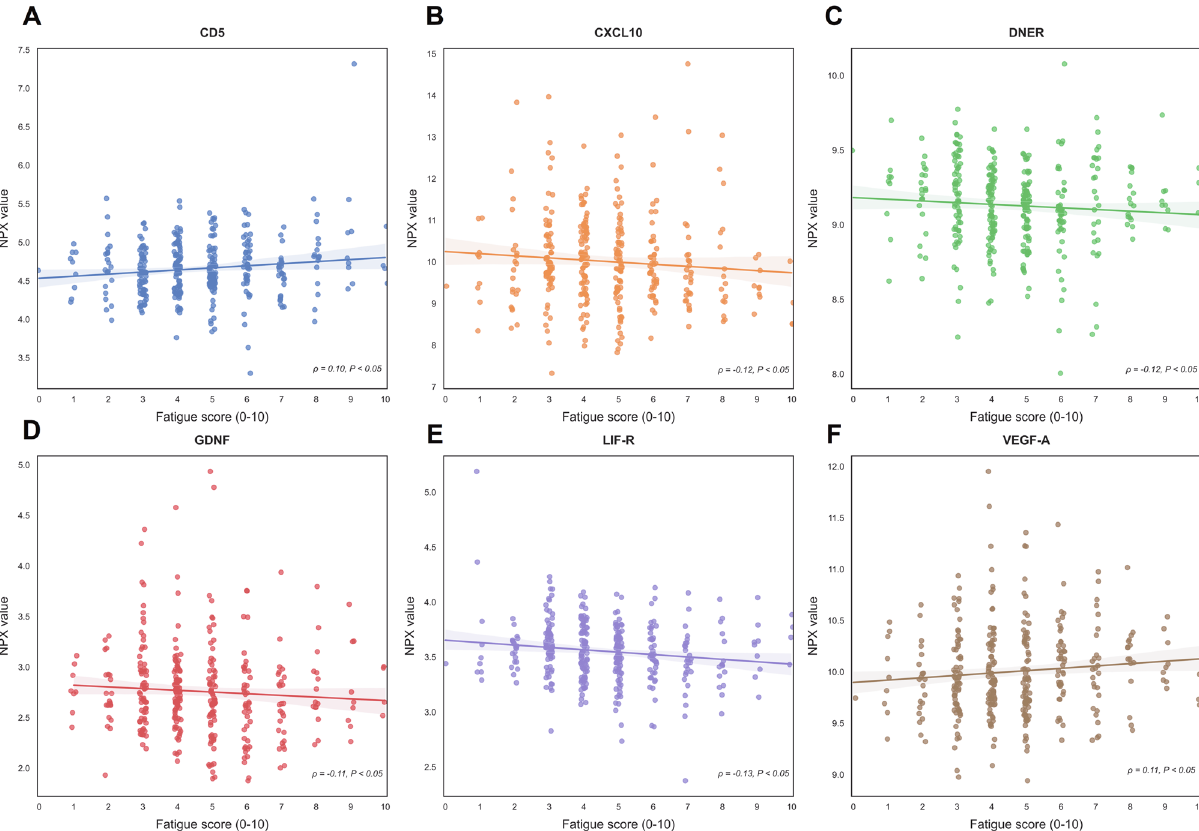
Figure 3. ( A – F ) Top six (6) differentially abundant plasma proteins between mildly fatigued (Q1) patients and severely fatigued (Q4) patients. Abbreviations: CD5, T-cell surface glycoprotein CD5; CXCL10, C-X-C motif chemokine ligand 10; DNER, Delta and Notch-like epidermal growth factor-related receptor; GDNF, glial cell line-derived neurotrophic factor; leukemia inhibitory factor receptor; NPX, normalized protein expression; vascular endothelial growth factor A (VEGF-A).